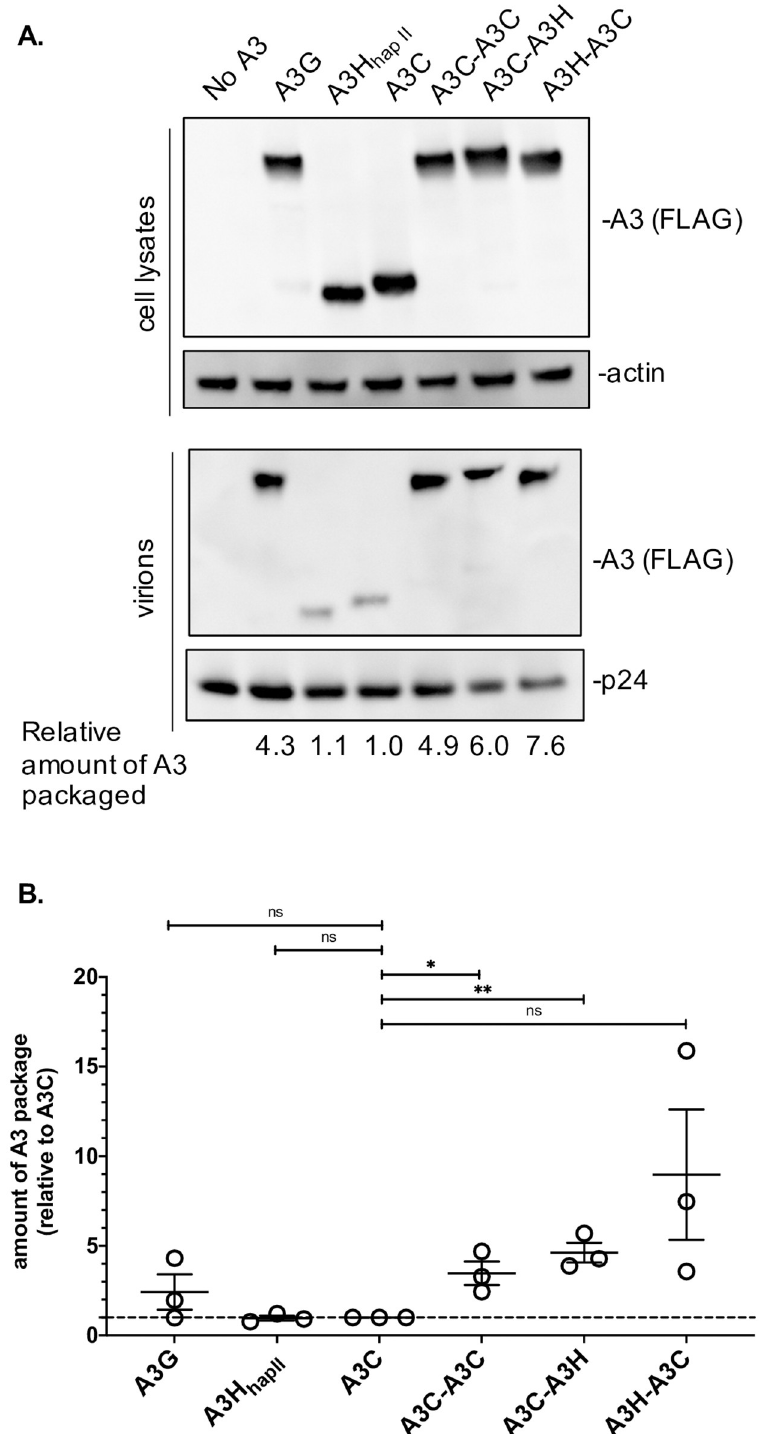
Fig 2. A3C/A3H double domains are packaged more than their single domain counterparts. (A) Intracellular expression and packaging of A3 into virions. HIV-1 Δ Env Δ Vif provirus was co-transfected into 293T cells with 100ng of each A3 . Top: western blot of cellular lysates probed with anti-FLAG antibody showing intracellular expression levels for A3s and actin as a loading control. Bottom: Western blot of proteins in the pelleted virions and probed with anti-FLAG antibody for A3 levels and anti-p24 gag for normalization. An empty vector condition was used as a